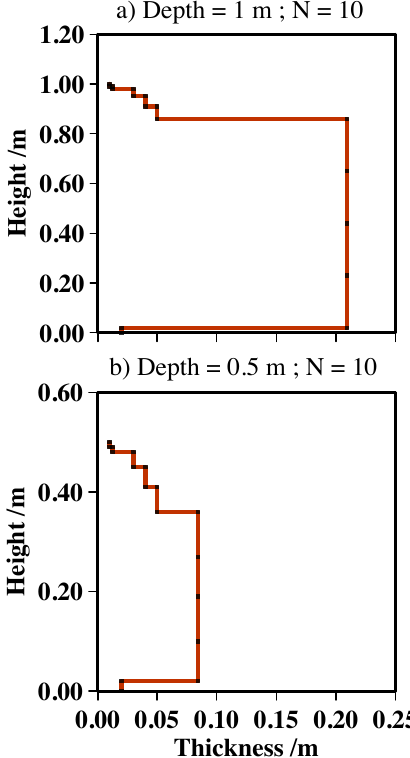
Fig. 4. Example of the idealized profile of the thickness of the nu- merical snow layers making up the snowpack handled by the snow- pack scheme Crocus, in the case where a maximum of 10 snow layers are allowed for a 1m and 0.5 m deep snowpack in panels (a) and (b) , respectively. See Sect. 3.2 for